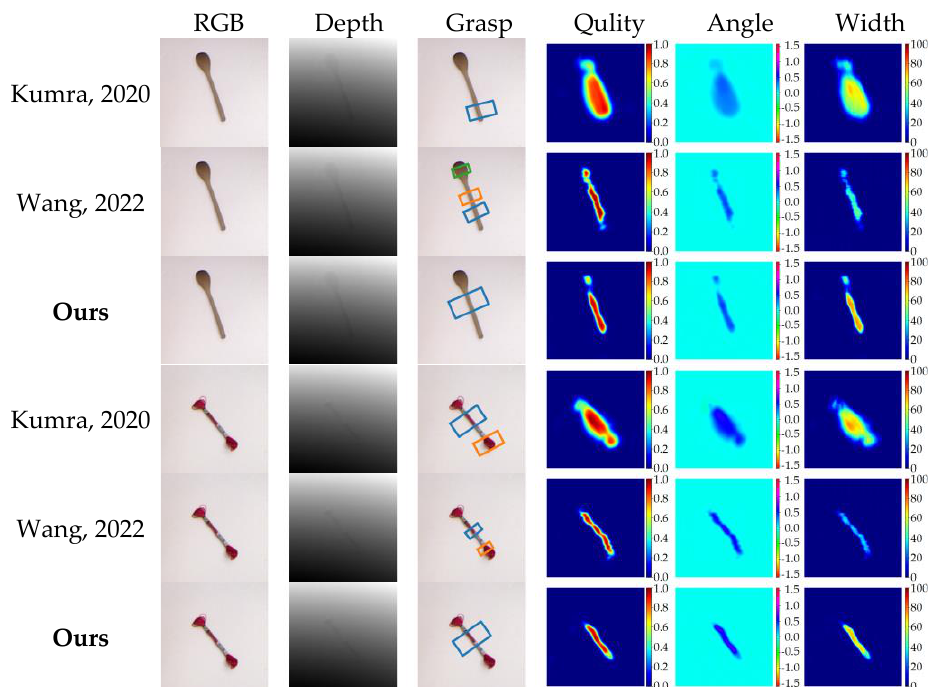
Figure 11. Experiment results of the algorithms proposed by Kumra et al. [8] in 2020, Wang et al. [6] in 2022 and our method on Cornell dataset. The 1st and 2nd columns are RGB image and depth images. The 3rd column shows grasp detection results. The last three columns illustrate the quality, angle, and width heatmaps.